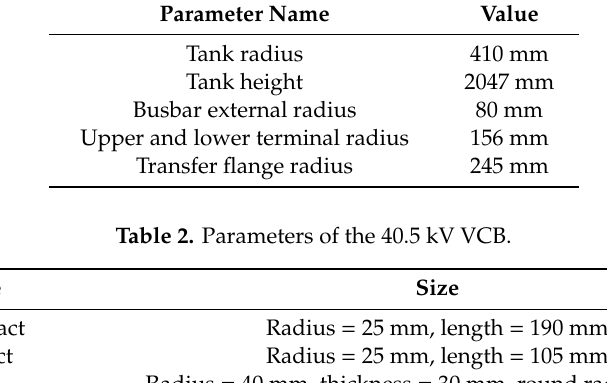
Table 1. Dimension of the 363 kV VCB.